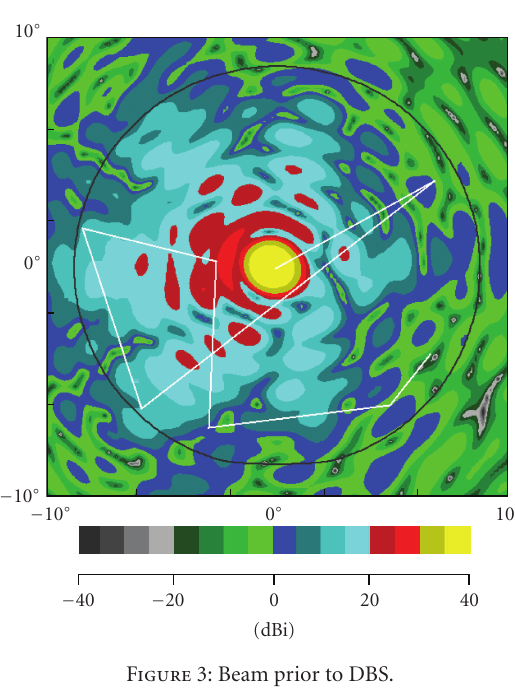
Figure 3: Beam prior to DBS.